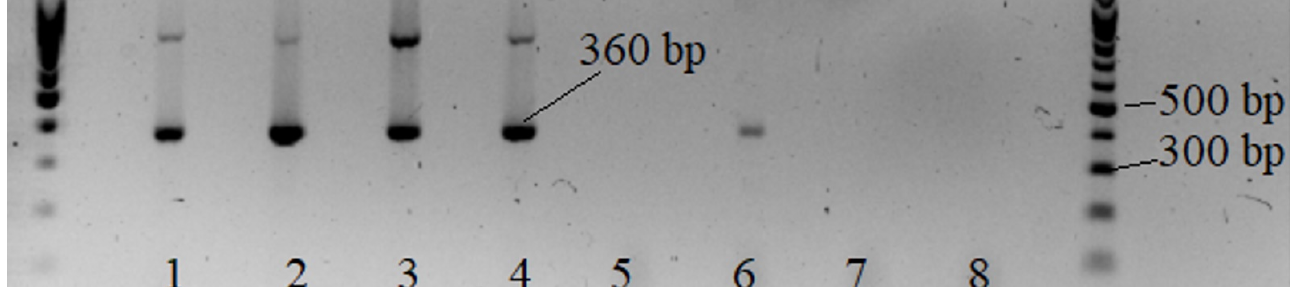
Figure 2. RT-PCR detection of PSTVd with the P3/P4 primers in Rutgers tomato plants inoculated with different PSTVd strains: 1—NicTr-3; 2 and 6—VP35; 3—VP87; 4—FP10-13; 5—Mock; 7 and 8—negative control (distilled water). On the sides of the gel are molecular weight markers 100 bp (Gene Ruller, Fermentas).